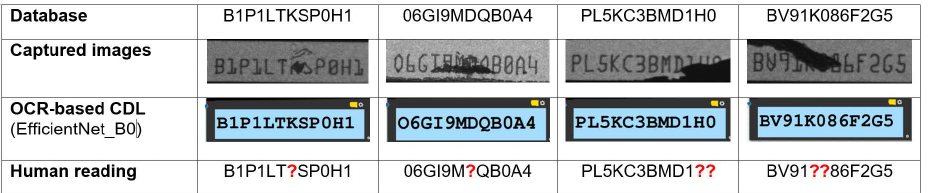
Figure 10. Recovery rates (%) and inference time (second) of four CNN networks and human reading.